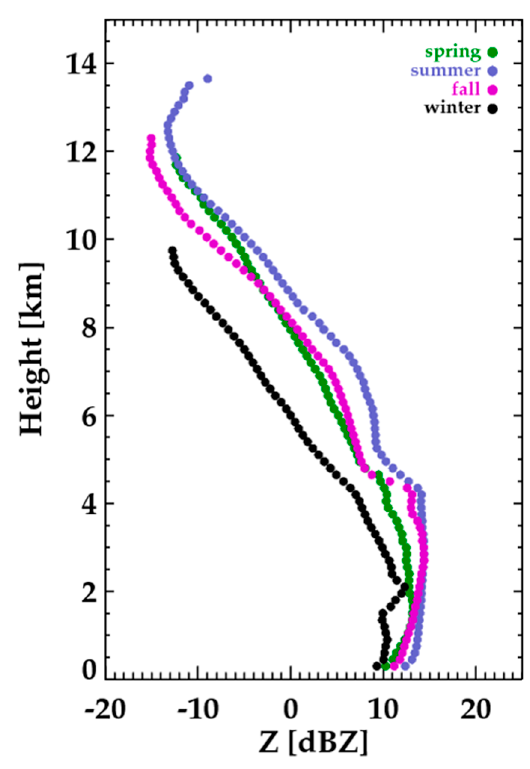
Figure 10. Vertical profiles of averaged reflectivity (Z) with seasons.